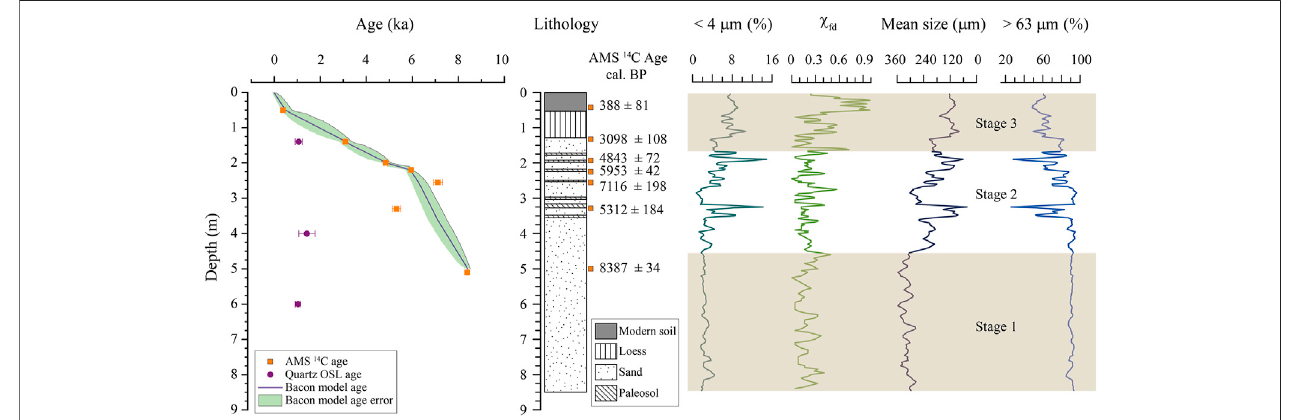
FIGURE 3 | Quartz optically stimulated luminescence (optically stimulated luminescence) and accelerator mass spectrometry (AMS) 14 C ages and Bacon age – depth model, lithology, grain size records, and the mass-speci fi c frequency-dependent magnetic susceptibility along the depth of the MQQ pro fi le.